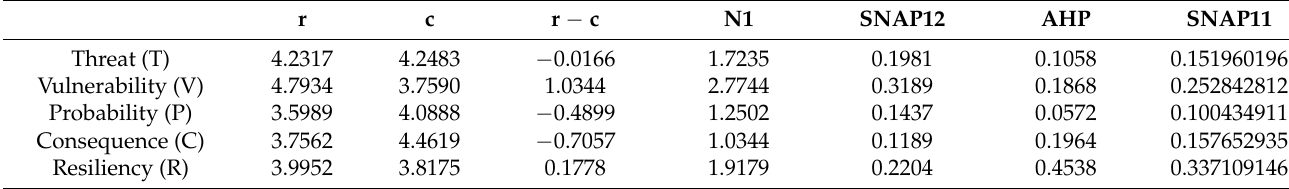
Table A4. Detailed calculations of SNAP11 criteria